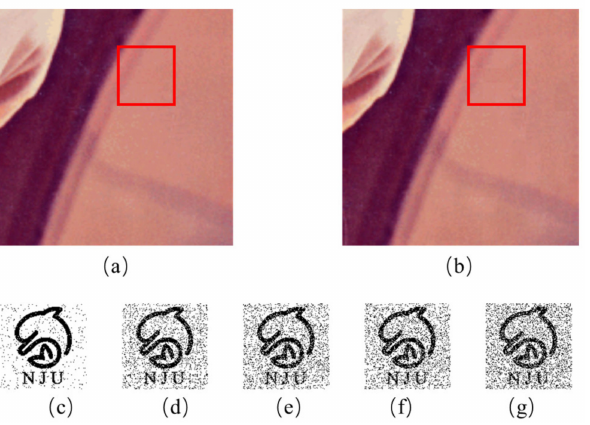
Figure 4. Watermarking experiments. ( a ) Part of the original image. ( b ) Part of the watermarked image when T is set as 0. ( c – g ) Extracted watermark patterns after JPEG compression (QF = 80) when T is set to 0, 8, 16, 24 and 255.